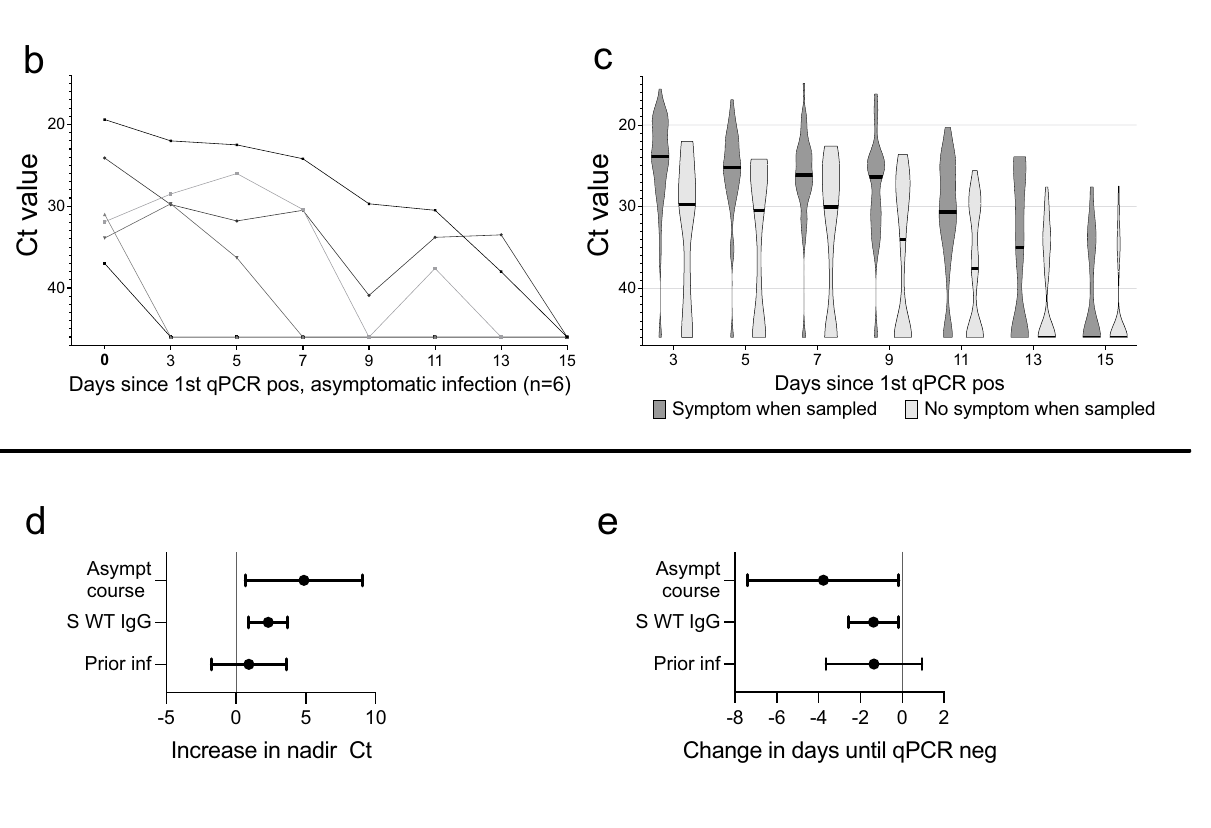
Fig. 2 | SARS-CoV-2 omicron viral load over the fi rst 15 days of infection, symptom relation to Ct values and effects on nadir Ct and duration of qPCR positivity. a Ct value during the fi rst 15 days of breakthrough infection in all qPCR positive participants ( n =60), and ( b ) in participants with an asymptomatic course ofinfection( n =6). c Ctvaluesinparticipantswhoweresymptomatic(darkgrey)or asymptomatic (light grey) at time of sampling. d Increase in nadir Ct by asympto- maticcourse of infection, per two-fold increase in WT spike-speci fi c IgG levels and